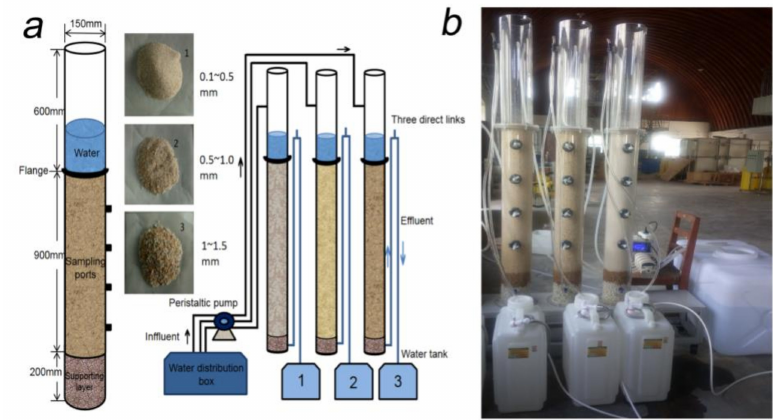
Figure 1. Experimental equipment. ( a ) Design drawing. ( b ) Physical